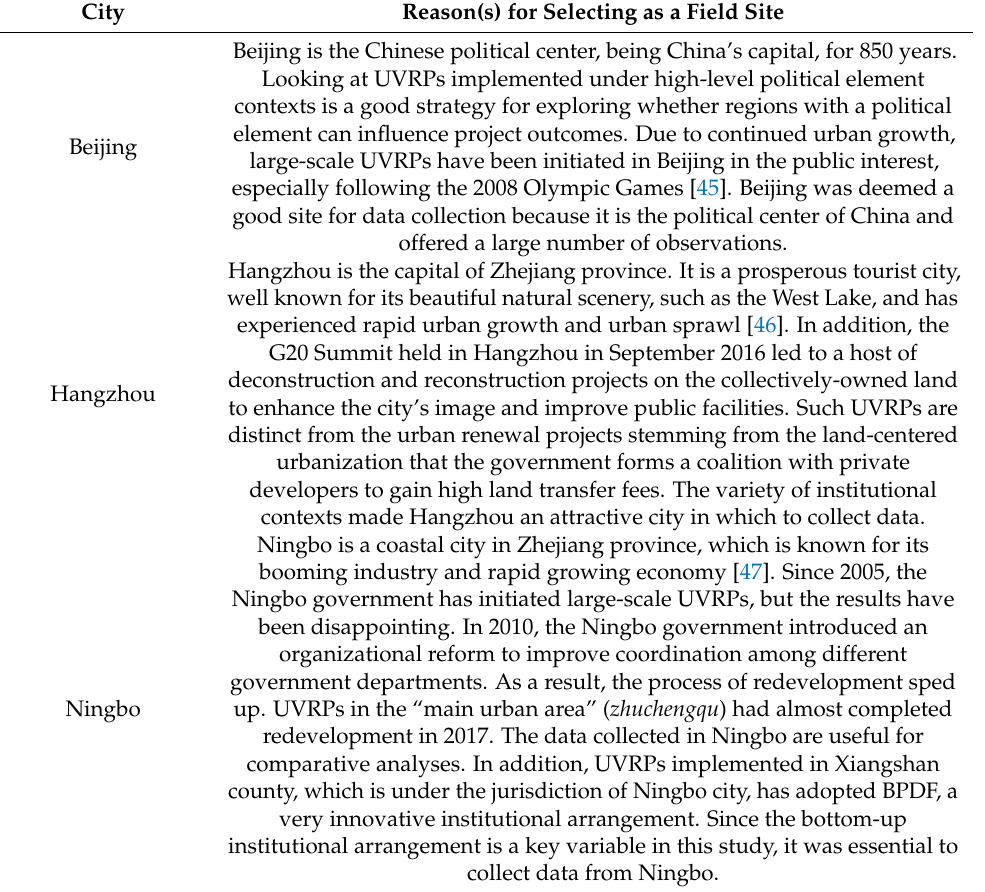
Table A1 details the reasons for selecting the field sites for the empirical studies. Table A1. The reasons for selecting field